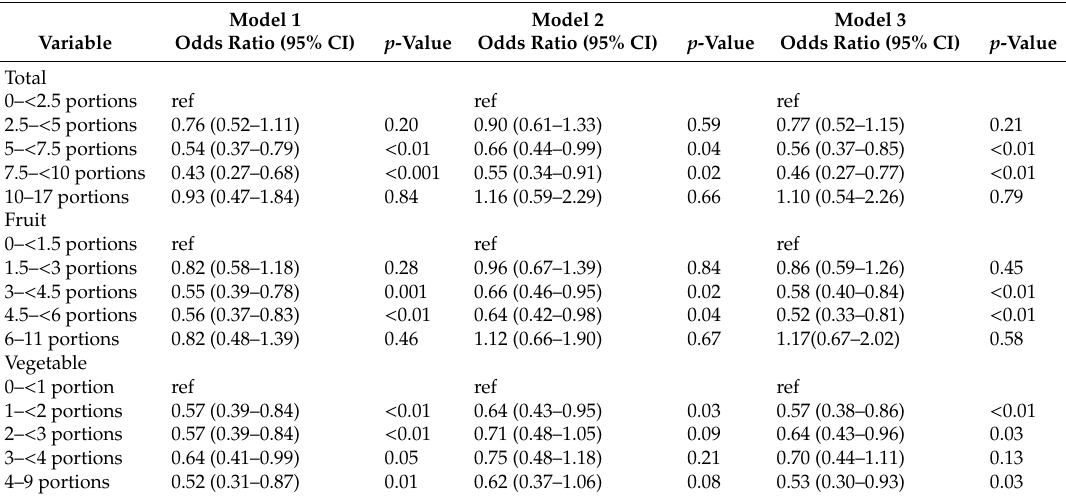
Table 3. Associations between daily fruit and vegetable consumption and incident prefrailty / frailty risk over 4 years among 1577 robust community-dwelling older people in